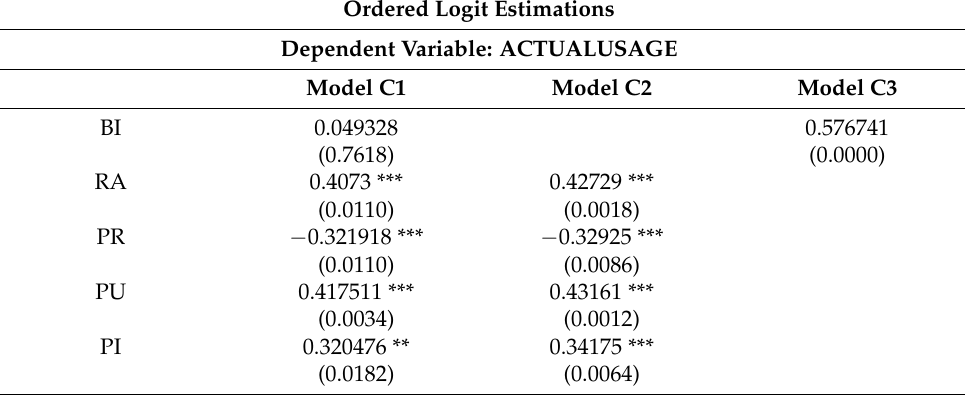
Table 8. Ordered Logit